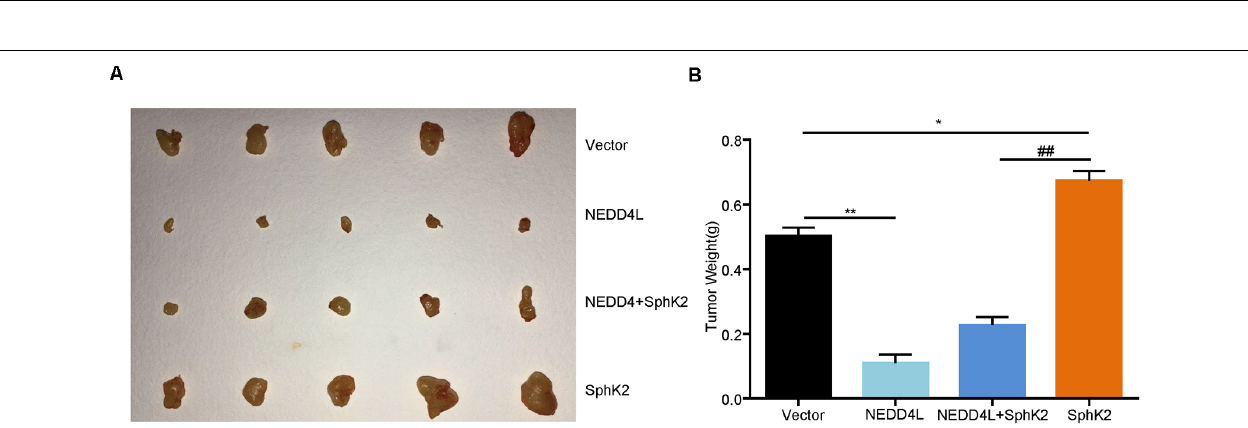
FIGURE 5 | Ubiquitination of SphK2 inhibits glioma cell progression through the AKT/ β -catenin pathway. (A–D) Glioma U251 cells were transfected with NEDD4L overexpression plasmid or siRNA and indicated proteins were detected by immunoblotting (IB). ** P < 0.01 compared with the vector; ## P < 0.01 compared with NC.